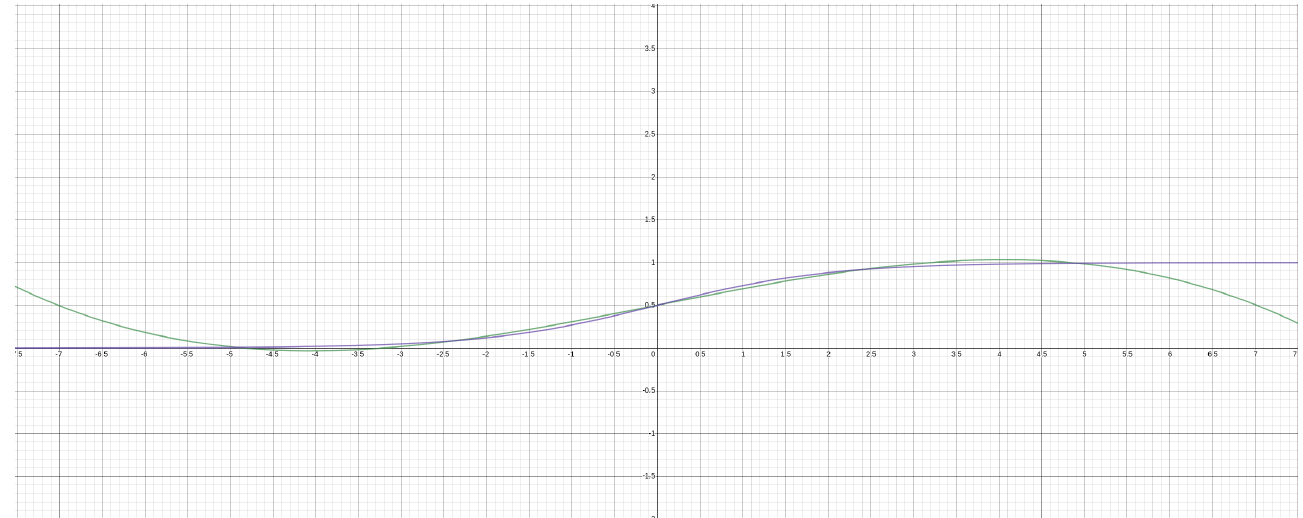
Figure 5. Graphical comparison of the sigmoid (purple) and sigmoid approximation (green) functions, showing their similarity between the range of − 5 and